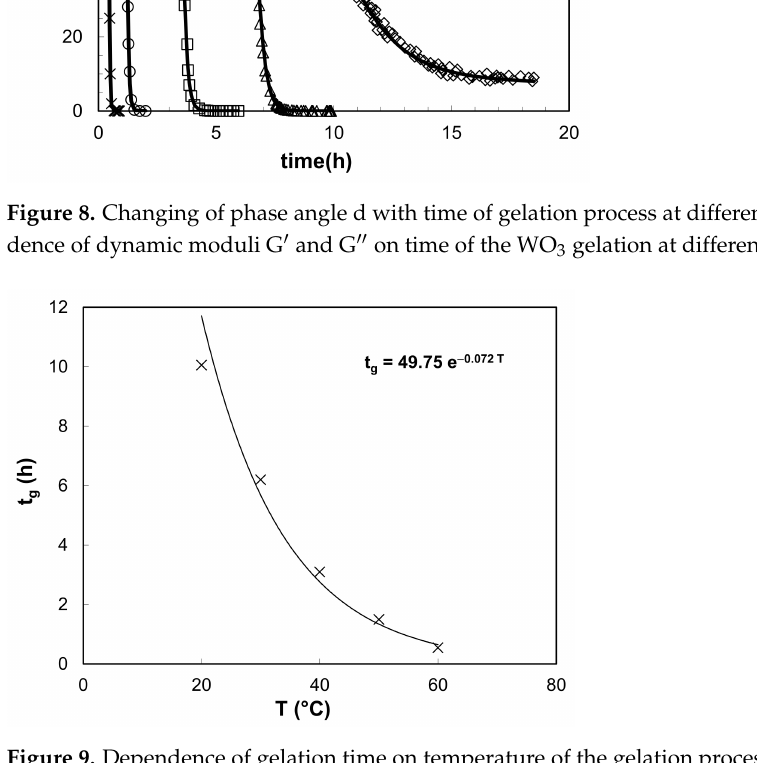
Figure 9. Dependence of gelation time on temperature of the gelation process of the WO 3